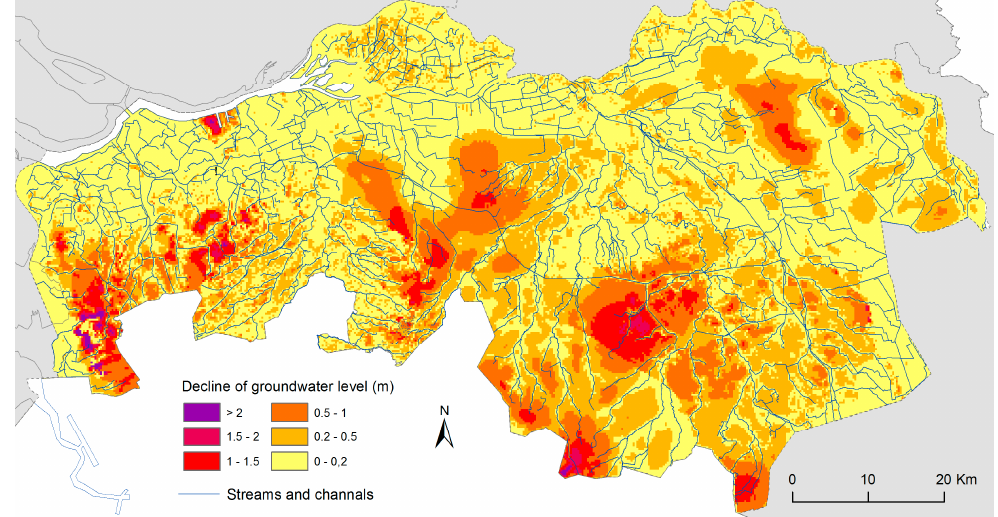
Figure 4. Simulated decline in groundwater level due to change in land use and increase of crop yields between 1950 and 2010.